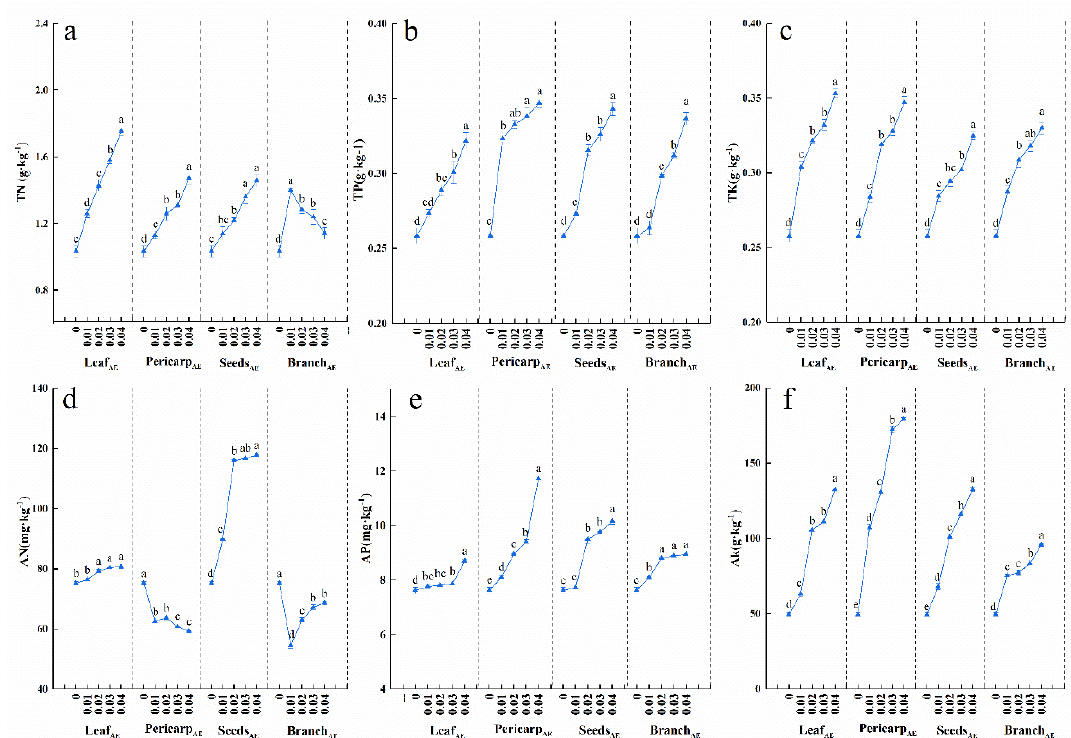
Figure 4. The TN ( a ), TP ( b ), TK ( c ), AN ( d ), AP ( e ), and AK ( f ) contents in soil planted with C. migao seedlings after litter aqueous extract treatments for 210 days. The x axis denotes the concentration of the aqueous extract, and the y axis denotes the content. Values are expressed as mean ± SE. The values marked with different letters are significant at p < 0.05 (Duncan’s